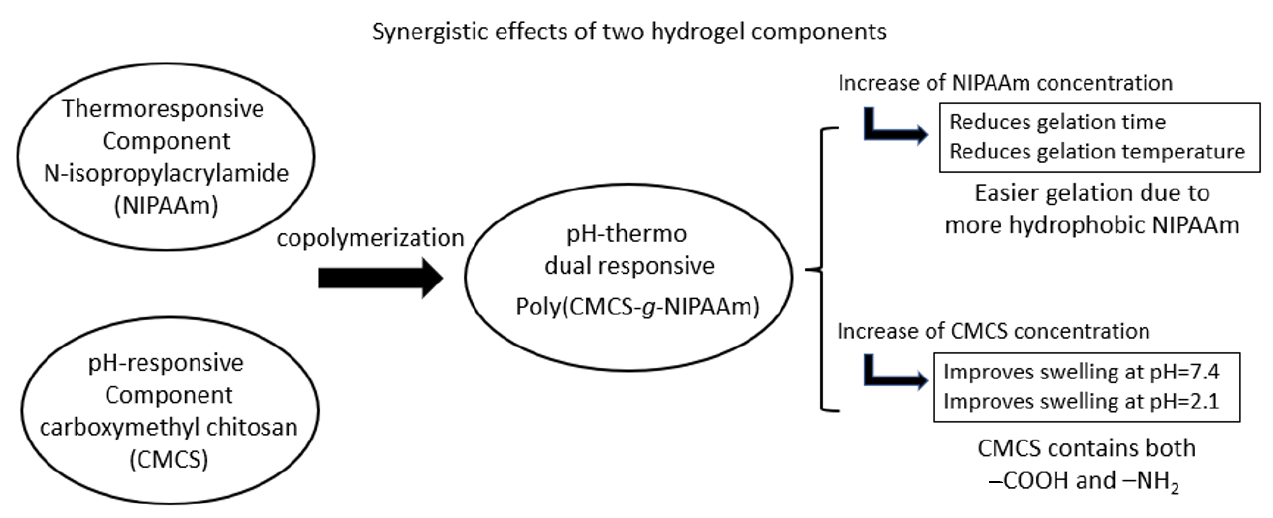
Figure 4. Synergistic effect of a pH-thermo dual responsive hydrogels composed of copolymer of poly(CMCS- g -NIPAAm).